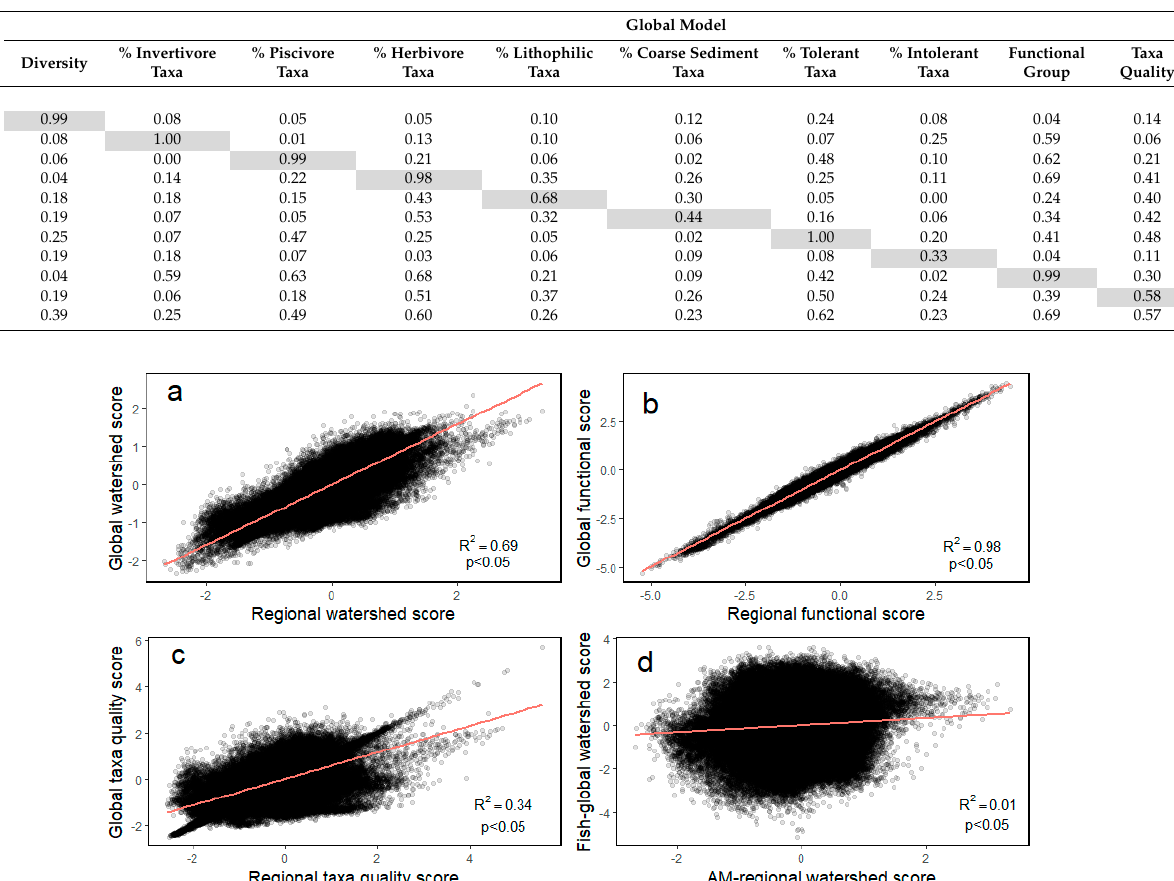
Figure 4. Plots show Pearson correlation between ( a ) global and regional watershed scores, ( b ) global and regional functional scores, ( c ) global and regional taxa quality scores, and ( d ) global watershed scores for fish and regional watershed score for aquatic macroinvertebrates (AM). Plots generated using Program R [30].